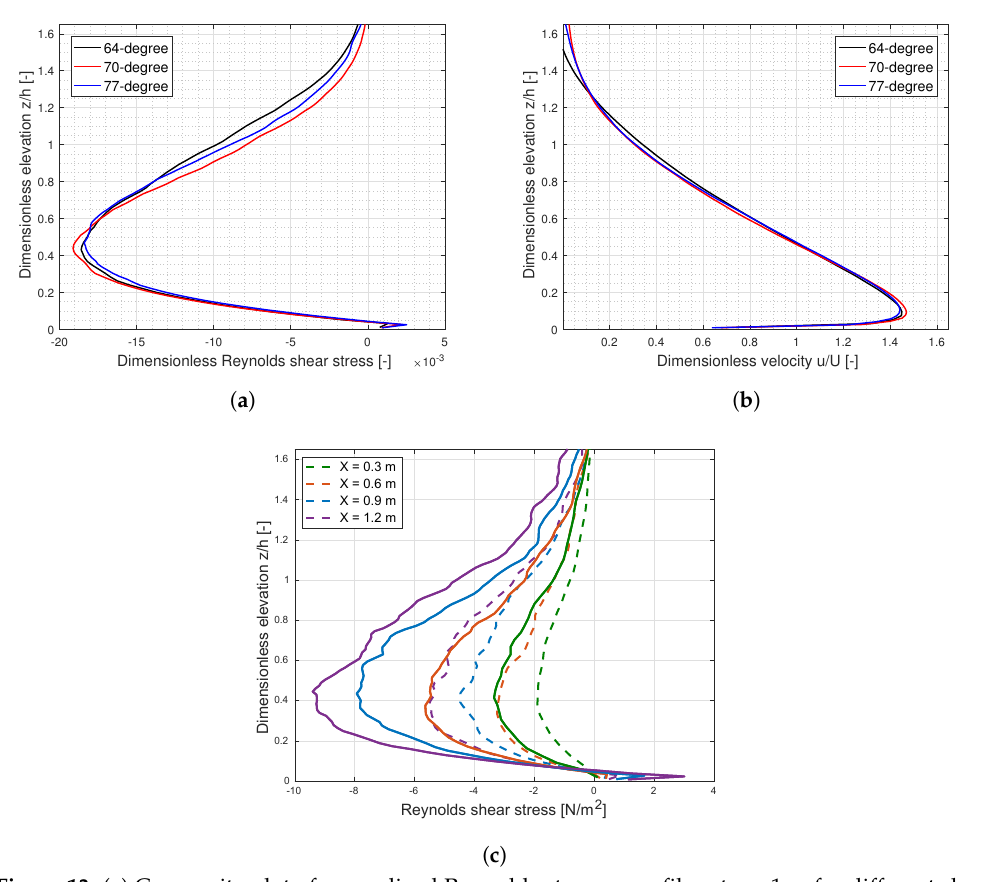
Figure 13. ( a ) Composite plot of normalized Reynolds stresses profiles at x = 1 m for different slope angles; ( b ) Composite plot of dimensionless velocity profiles at x = 1 m for different slope angles; ( c ) Composite plot of Reynolds stresses profiles spaced by a distance of 0.3 m: dashed lines correspond to 64 ◦ breach face and solid lines correspond to 77 ◦ breach